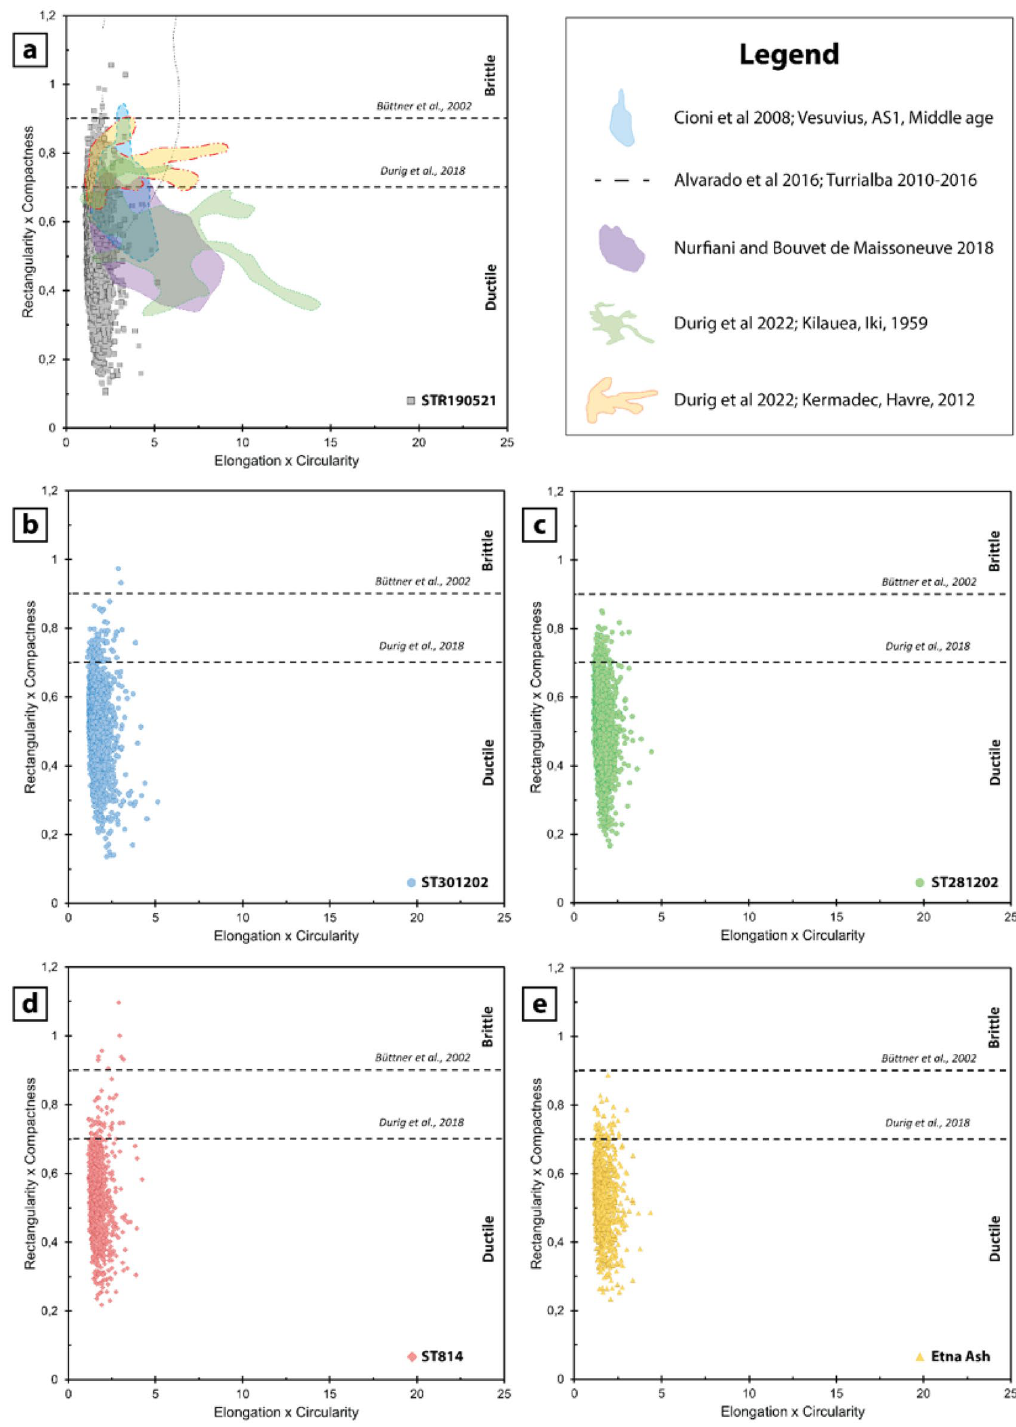
Figure 8. Elongation × Circularity versus Rectangularity × Compactness plot, modified after 61 , aim to identify the fragmentation style by means of particle shapes. Two thresholds, suggested by Büttner et al. 61 and Dürig et al. 63 are shown as dashed horizontal lines, separating the field of particles generated by brittle fragmentation (at the top), from those produced by ductile fragmentation (at the bottom). Each plot shows one individual sample, and the fields of some literature samples, reported in the legend, are